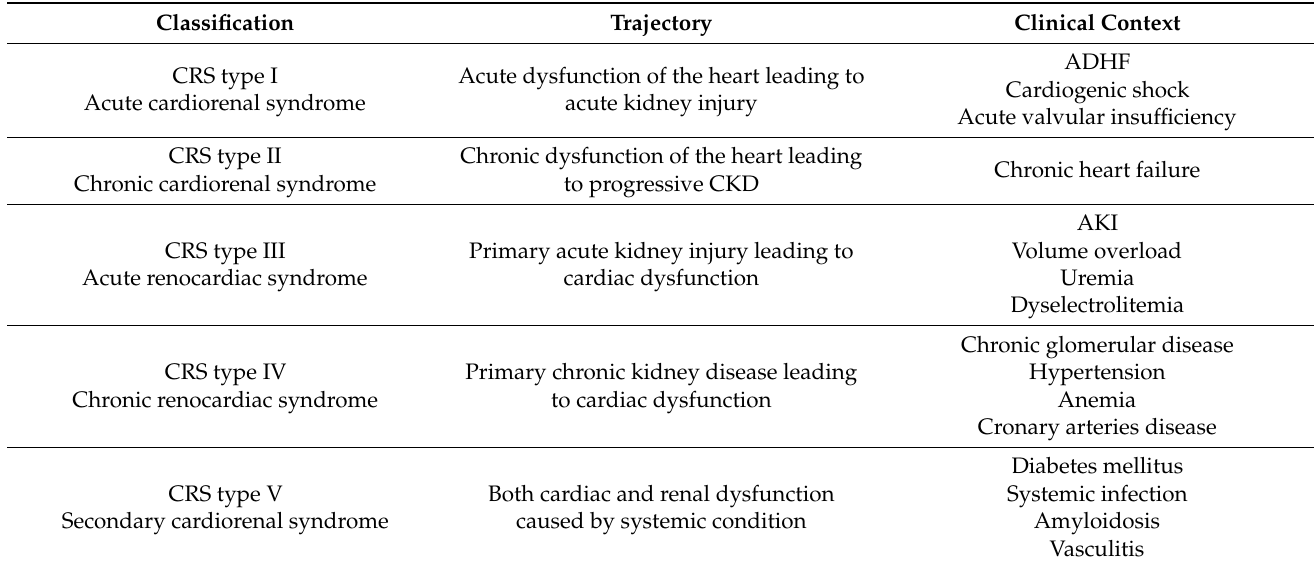
Table 1. Classification of cardiorenal